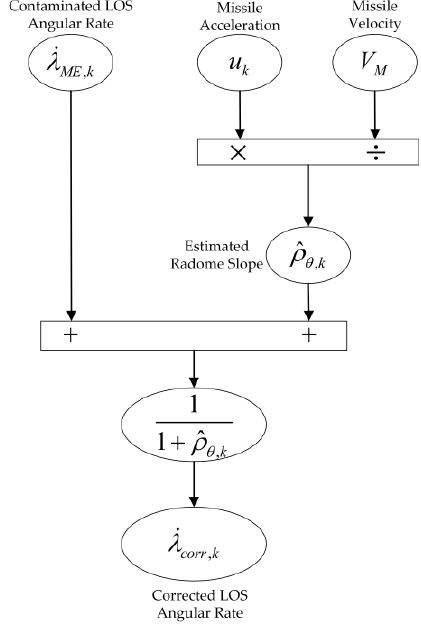
Figure 14. Flowchart of the proposed LOS angular rate corrector.